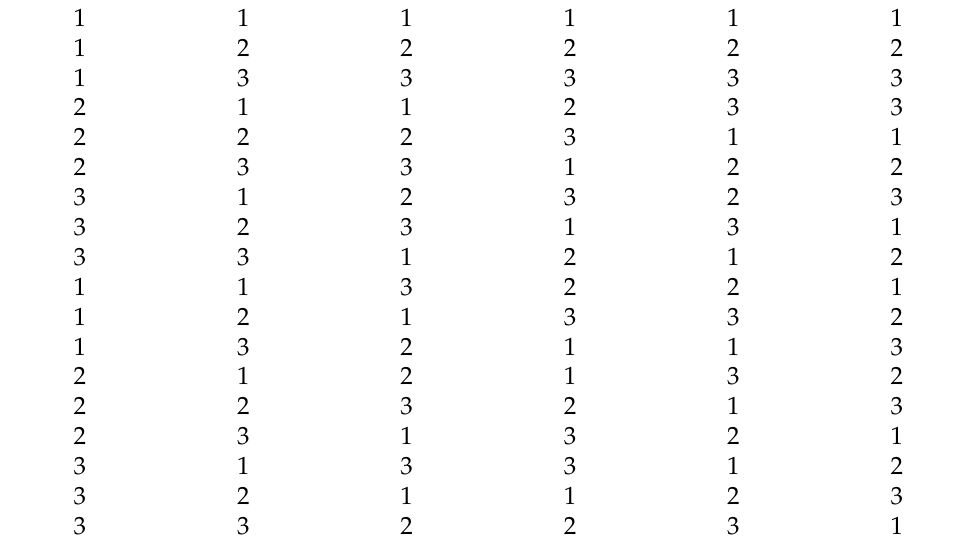
Table 5. Example of design of experiment techniques: Taguchi’s L 18 orthogonal array. Each row reports a combination of uncertain parameters to be evaluated. The 1, 2 and 3 are the discrete levels that represent respectively lower than nominal, nominal and higher than nominal values. Each column corresponds to one of the uncertain parameters and shows its value expressed by the aforementioned